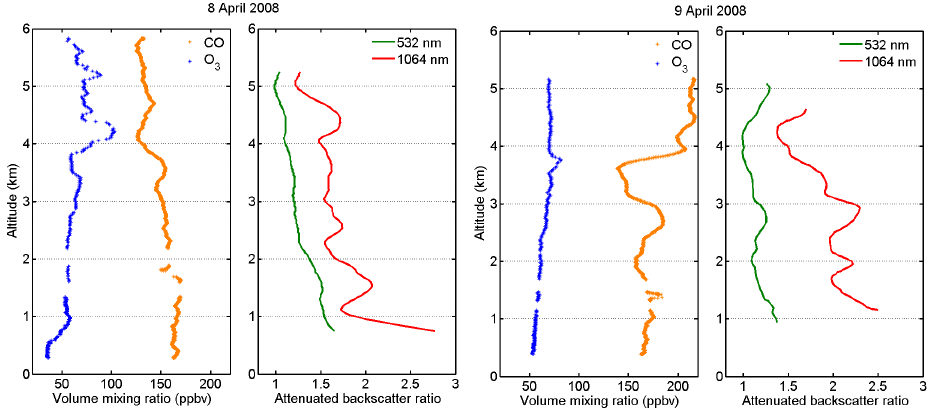
Fig. 13. Ozone and CO in situ measurements together with lidar total attenuated backscatter ratio during the two soundings. On the second one (9 April 2008) a layer with enhanced CO above 3.7km indicates pollution transport.